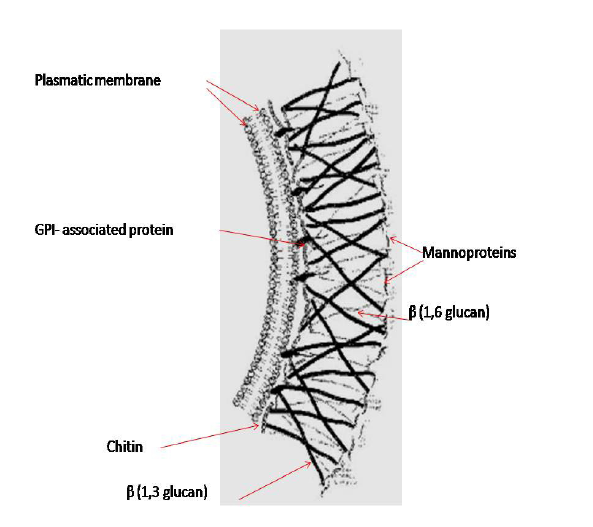
Fig. 1. Fungal cell wall (Selitrennikoff,